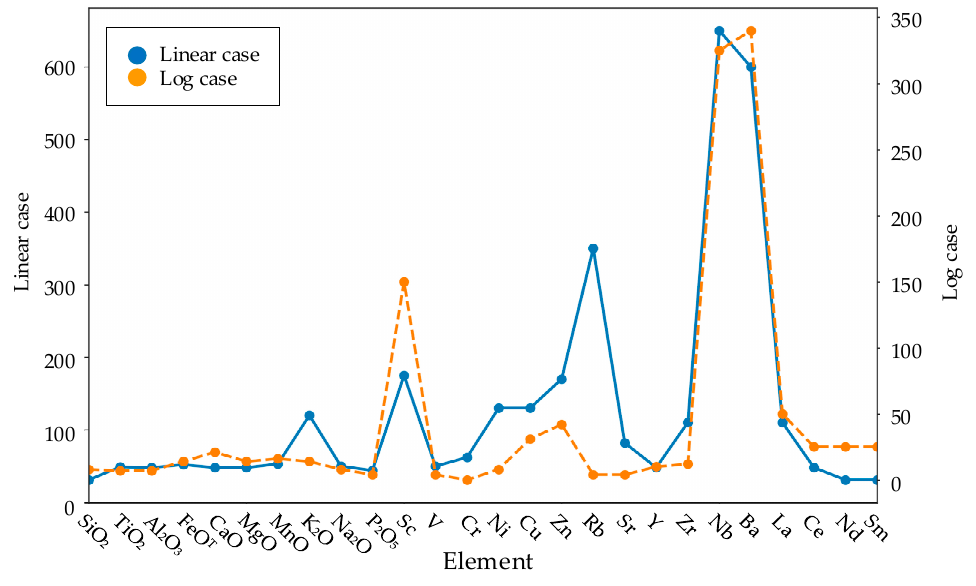
Figure 13. Statistics of the frequency of occurrence of the 26 basic elements in useful IAG and non-IAG discrimination diagrams.